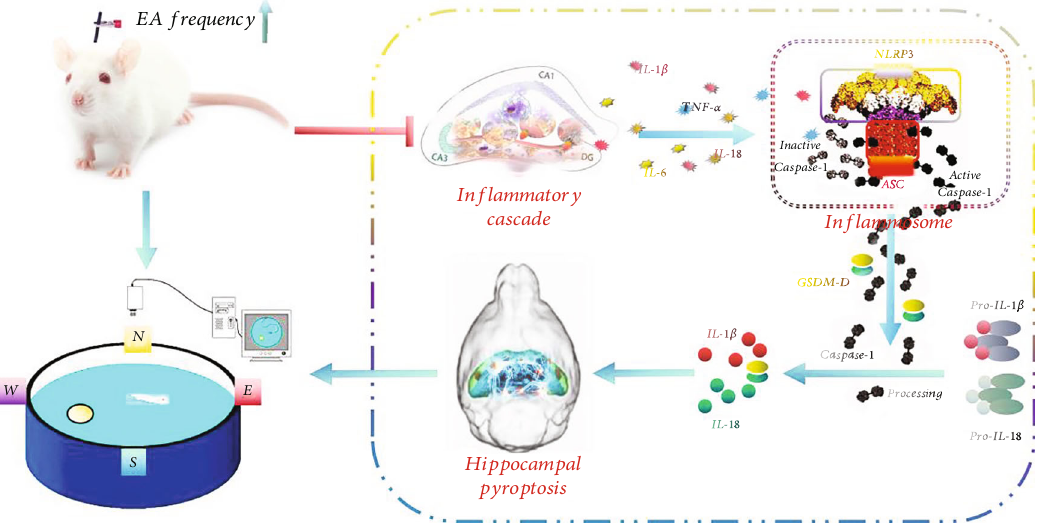
Figure 7: EA inhibited the activation of NLRP3 in fl ammasome to improve cognitive impairment. The attenuation of NLRP3 in fl ammasome activation ultimately reduced IL-1 β , IL-18, and GSDM-D expressions and attenuated the in fl ammatory response of the hippocampus, thereby inhibiting hippocampal pyroptosis to improve cognitive impairment in SAMP8